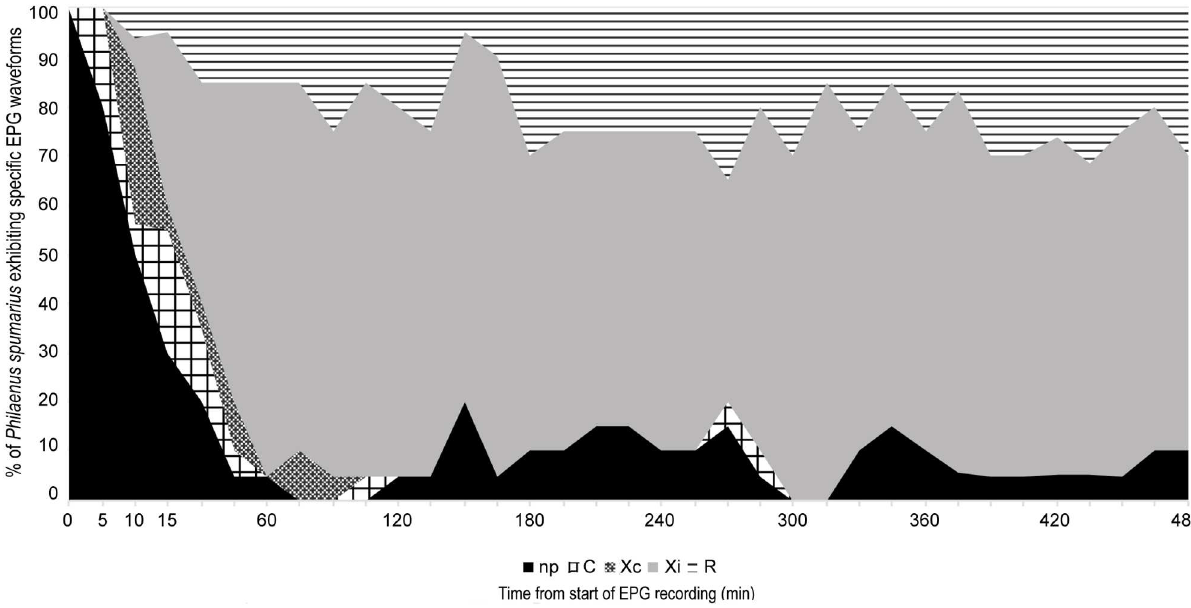
Fig 5. Temporal development of stylets activity for female P . spumarius on